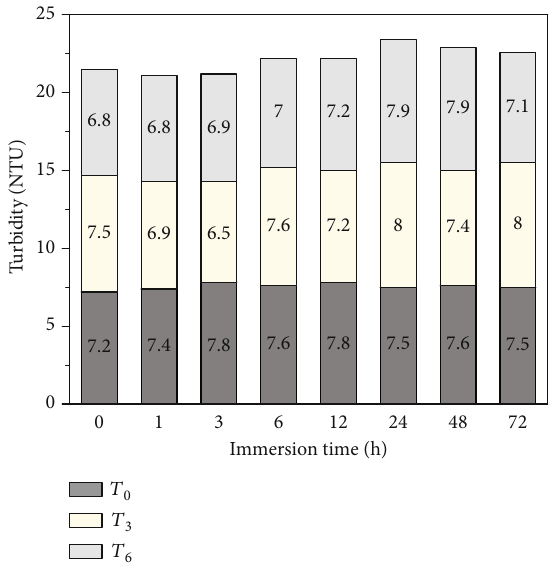
Figure 11: The e ff ect of immersion time on the